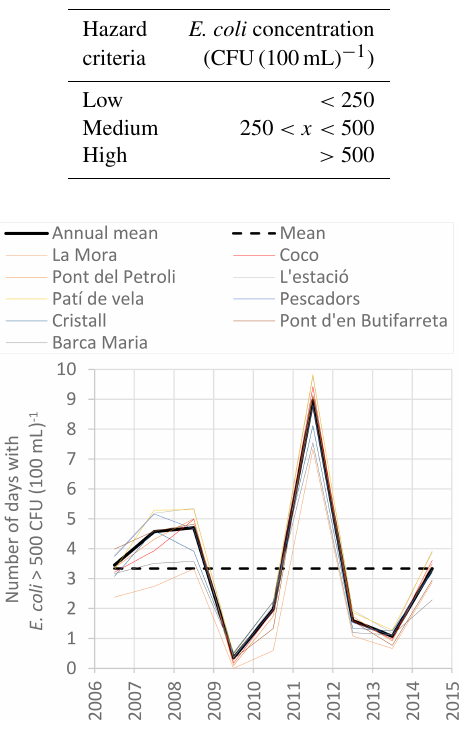
Figure 9. Simulated number of days per bathing season with high hazard ( E. coli concentrations > 500CFU(100mL) − 1 ) at all the different beaches of